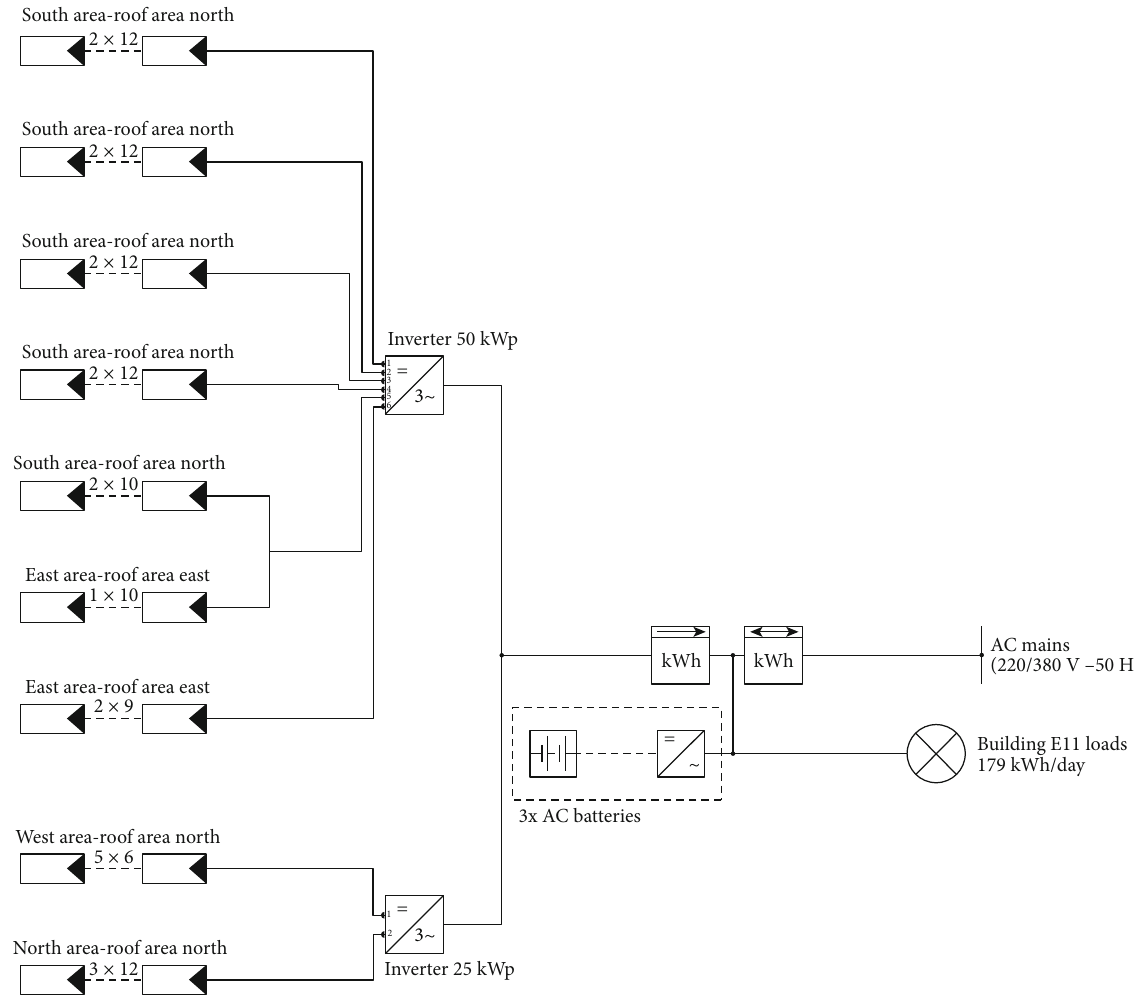
Figure 12: Schematic design of BAPV system connected to grid and BESS for E11